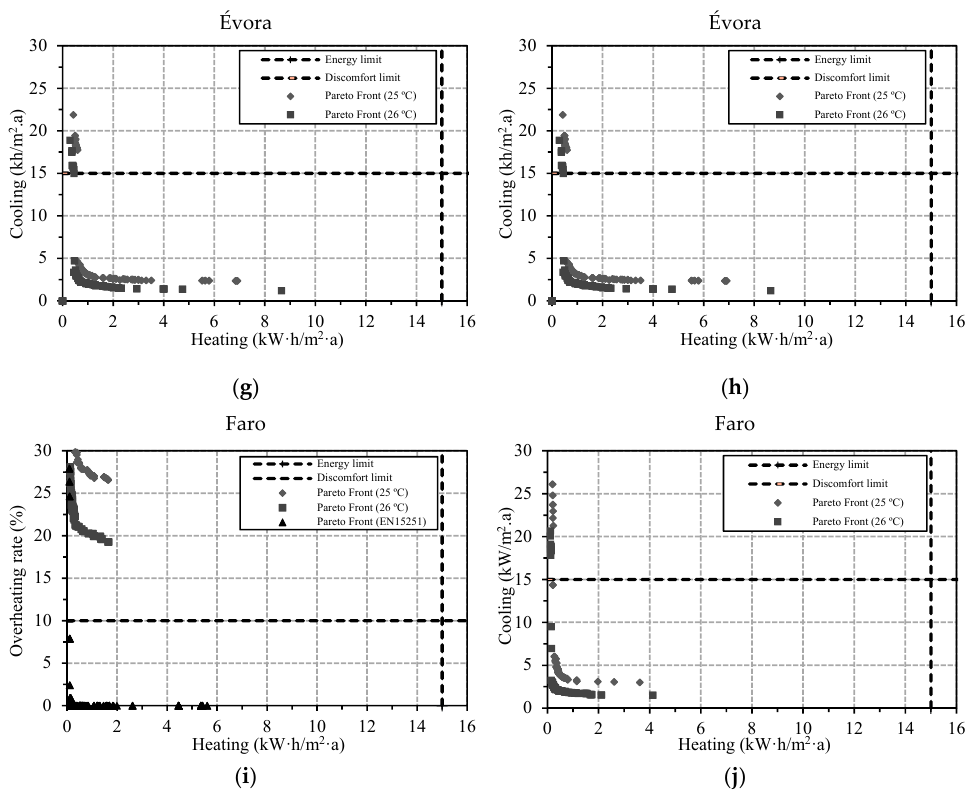
Figure 14. Pareto front results for all regions: ( a , c – e , g , i ) heating vs. overheating rate; ( b , f , h , j ) heating vs. cooling.